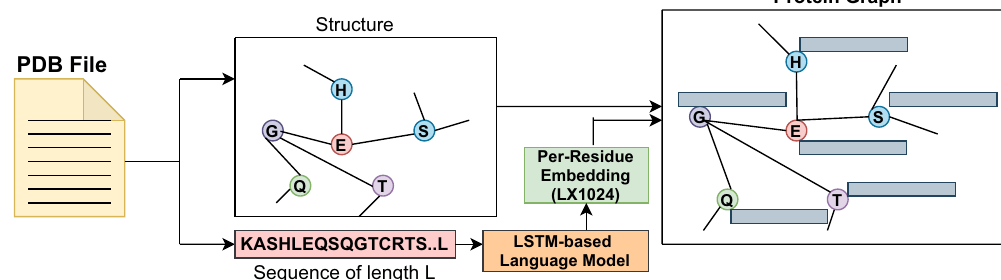
Figure 1. Graph representation of a protein with node features.